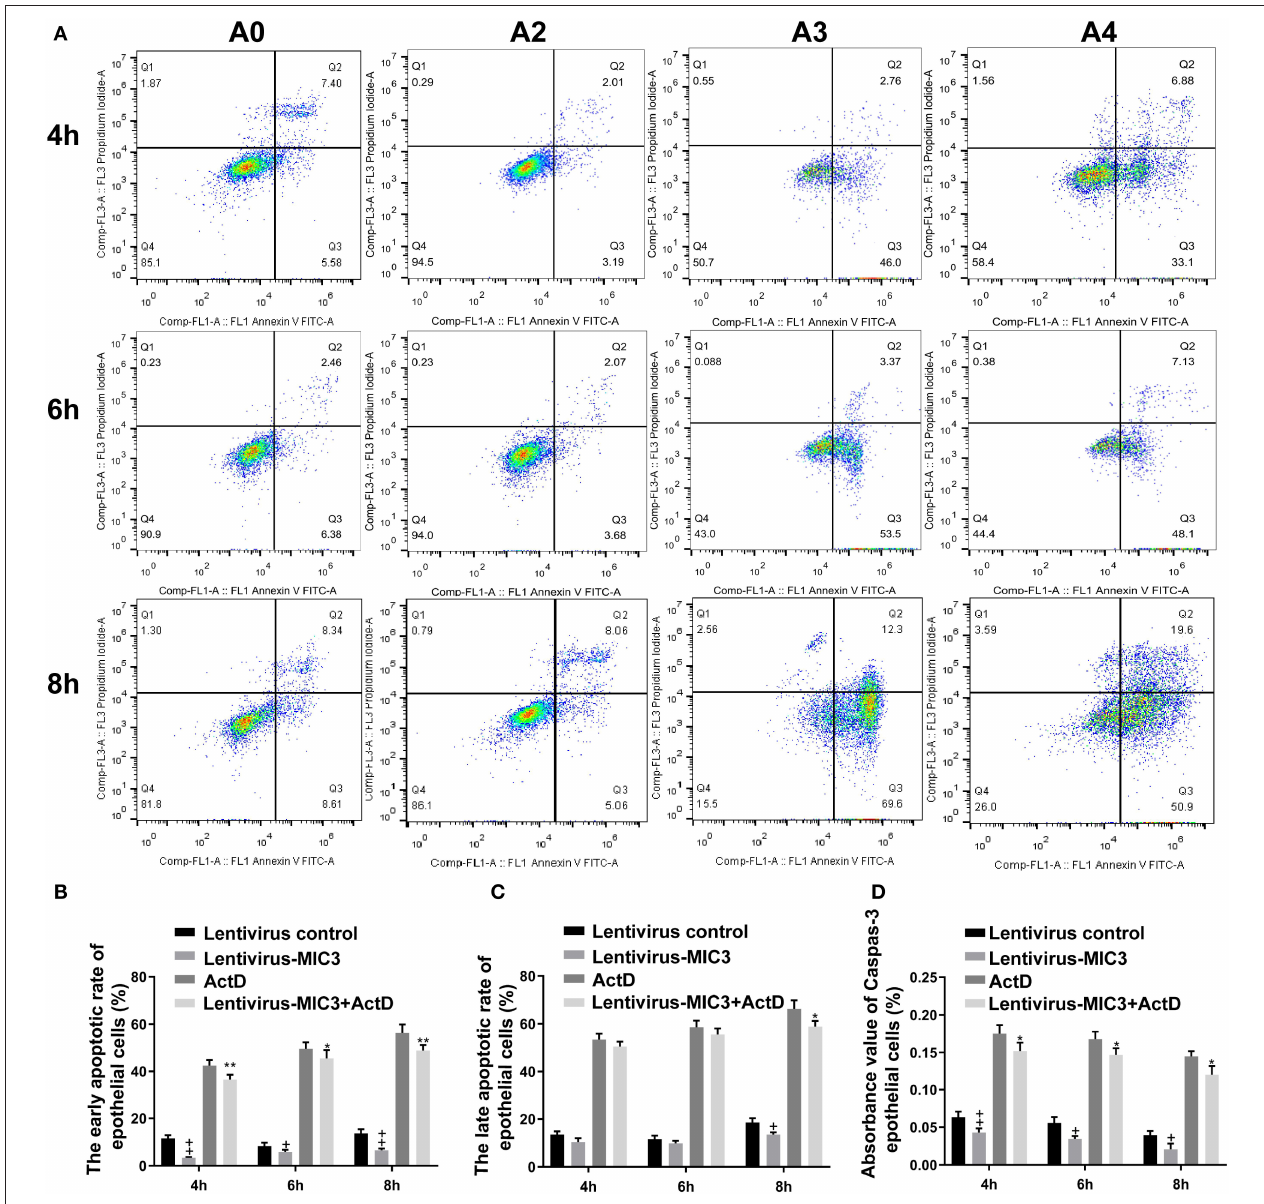
FIGURE 3 | Effects of early and late apoptosis on epithelial host cells after MIC3 protein expression. (A) The apoptosis/necrosis rate of chick duodenal epithelial cells was detected by Annexin V/PI assay after MIC3 expression. (B) Quantitative determination of the early apoptosis/necrosis rates after MIC3 expression ( n = 3). (C) Quantitative determination of the late apoptosis/necrosis rates after MIC3 expression ( n = 3). (D) Caspase-3 activity after MIC3 expression ( n = 3). + P < 0.01 vs. the control. “ + ” represents the apoptotic rate of host cells in Lentivirus-MIC3 group was significantly lower than that in Lentivirus control group ( + P < 0.05). “ + the apoptotic rate of Lentivirus-MIC3 group was significantly lower than that in the Lentivirus control group ( + P < 0.01). “*” represents the early apoptotic rate of host cells in Lentivirus-MIC3 + Act D group was significantly lower than that in Act D group ( + P < 0.05). “**” represents the early apoptotic rate of Lentivirus-MIC3 + Act D group was significantly lower than that in the Act D group ( + P < 0.01). T -test were used to statistically analyze the data. A0 represents the blank control group. A2 represents MIC3 protein infection group. A3 represents Act D infection group. A4 represents MIC3 + Act D infection